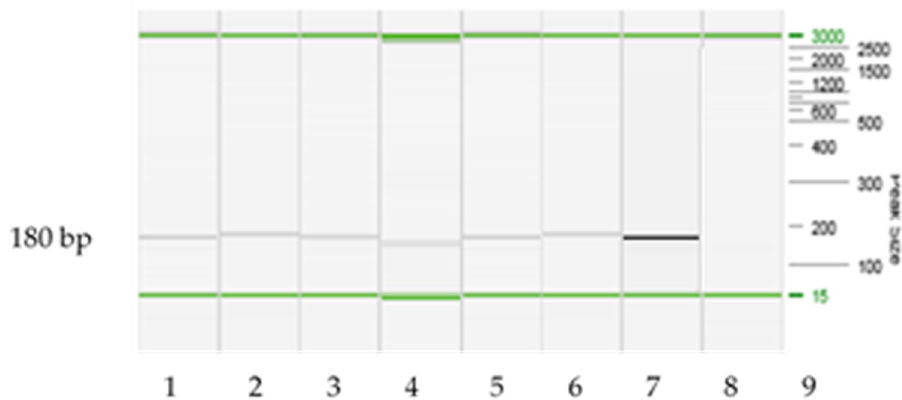
Figure 1. Gel electrophoresis of RT-PCR-amplified RNA analyzed in QIAxcel System, Qiagen. Lane 1–6, positive samples yielding amplicons of the expected size (180 bp); lane 7, positive control; lane 8, negative control; lane 9 DNA ladder.